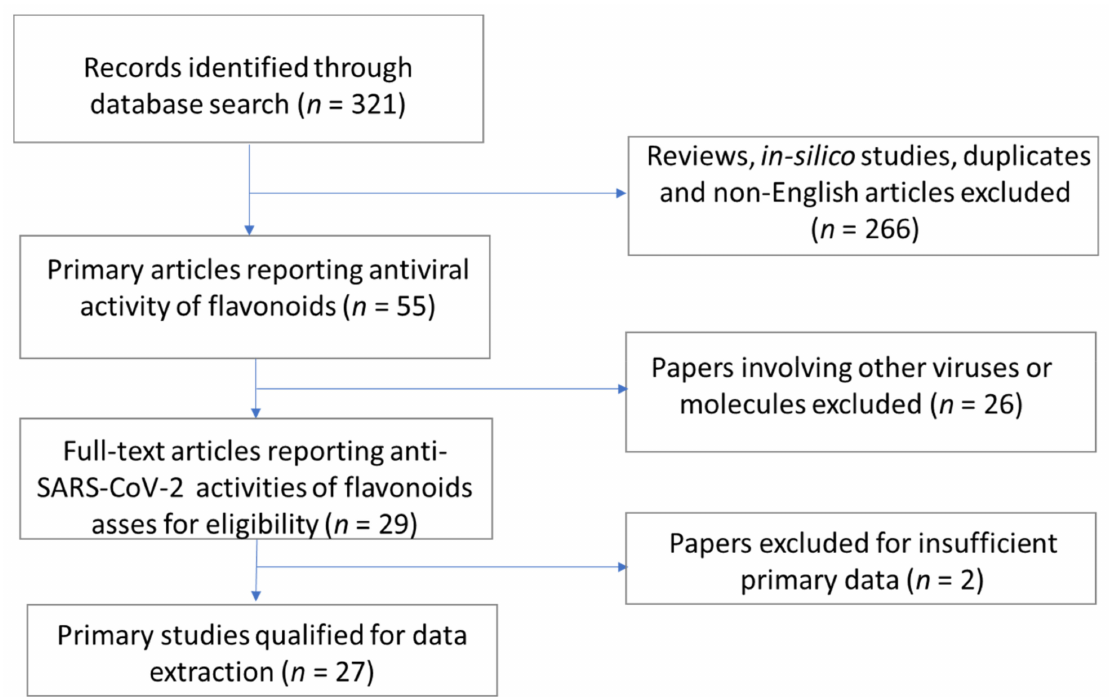
Figure 3. Flow chart of the search